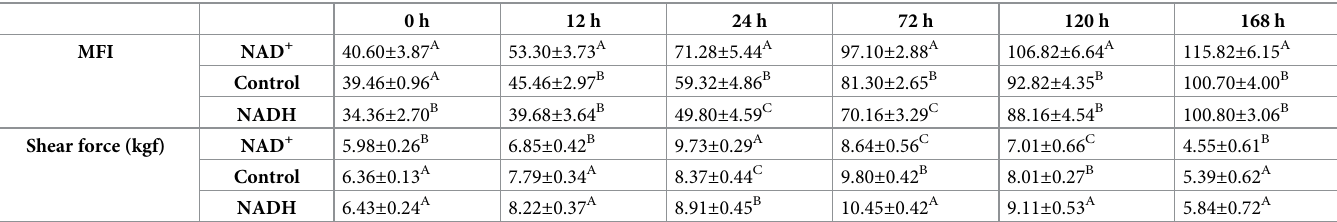
Table 3. Effect of NAD + and NADH on changes in meat tenderness in yak LT muscle.